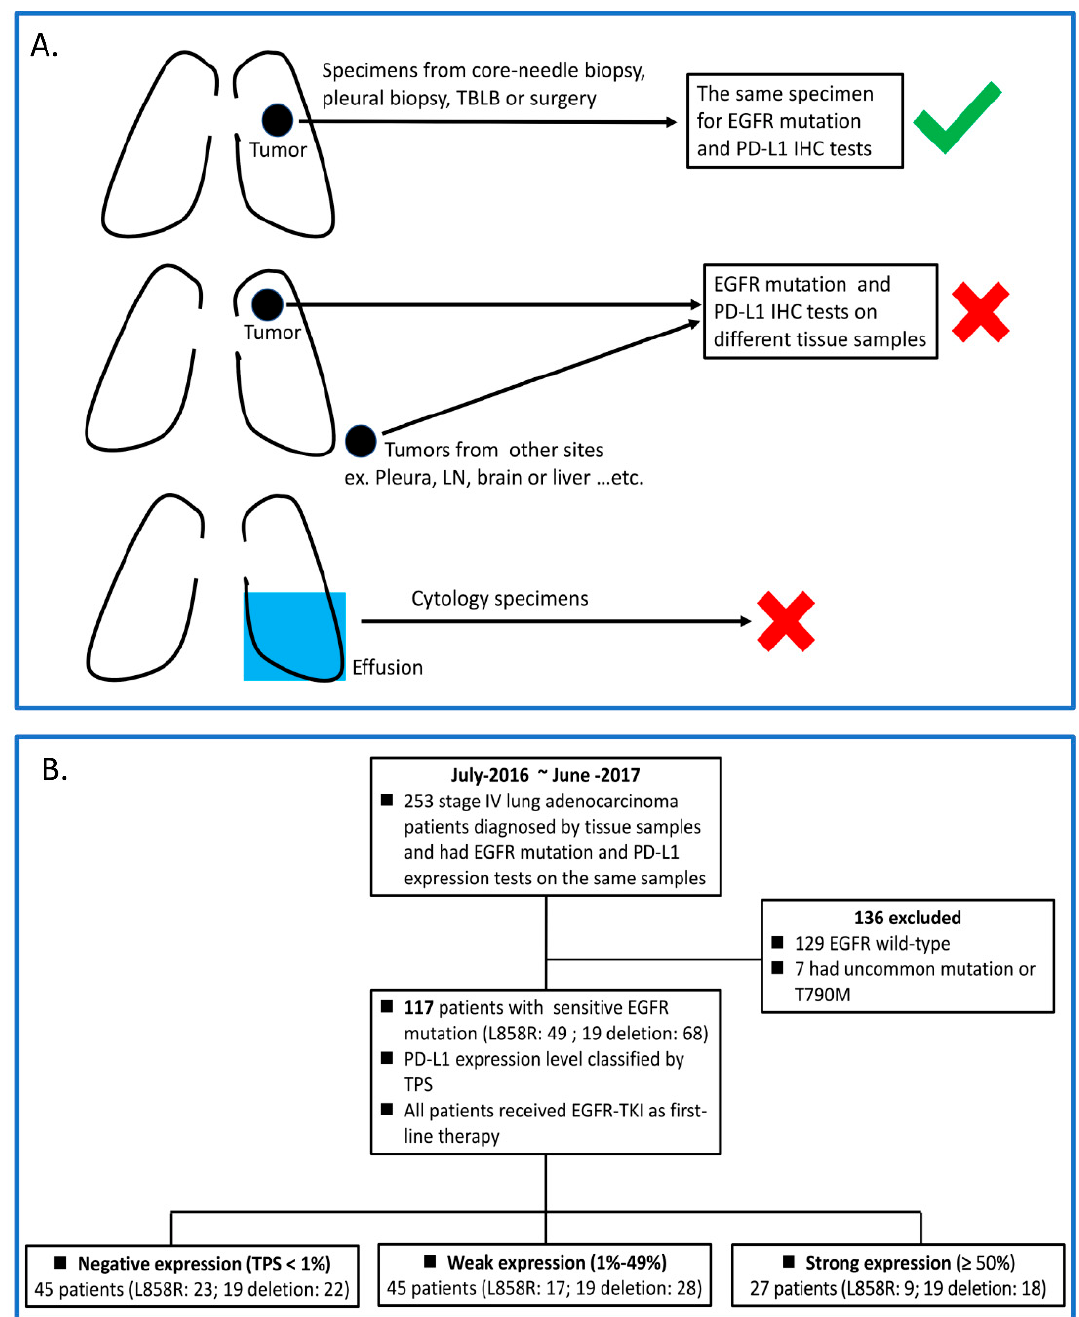
Figure 1. ( A ) Scheme of patient inclusion and exclusion criteria in this study; ( B ) Flow chart of the study. TBLB, transbronchial lung biopsy; EGFR, epidermal growth factor receptor; TKIs, tyrosine kinase inhibitors; PD-L1, programmed death ligand 1; IHC, immunohistochemistry; TPS, tumor proportion scores.